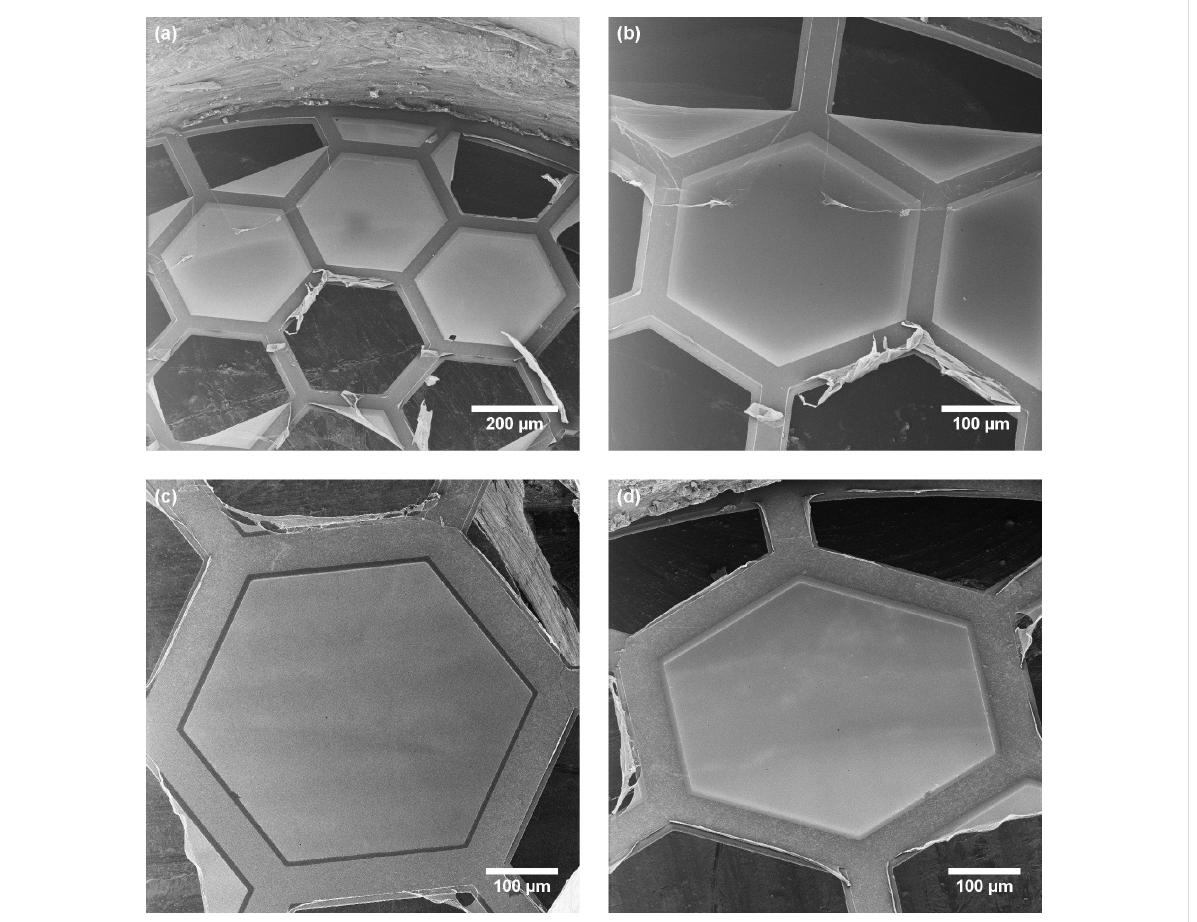
Figure 3: Examples of large freestanding CNMs. (a, b) Three intact CNMs are imaged at different magnifications. (c, d) Another intact CNM is imaged at different tilt angles. This comparison reveals that the intensity variation on the CNM surface originates mostly from secondary electrons emitted by the sample holder. Detailed information on all HIM images is given in Supporting Information File 1, Tables S1 and S2.